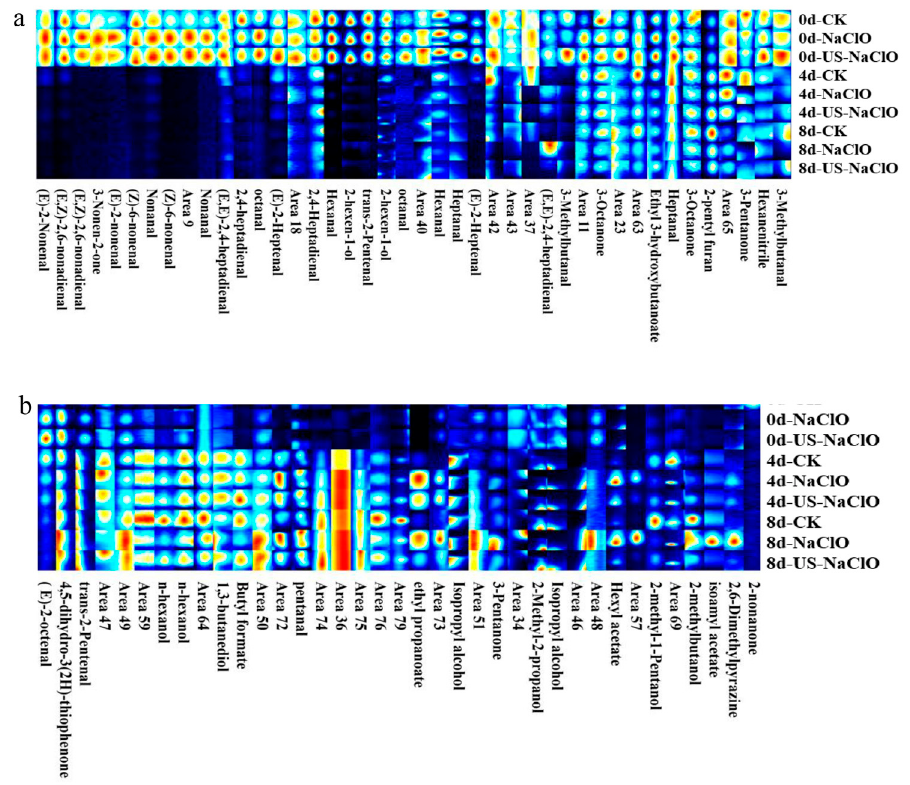
Figure 7. Fingerprints of volatile organic compounds in fresh-cut cucumbers under different treat- ments. ( a , b ): magnified